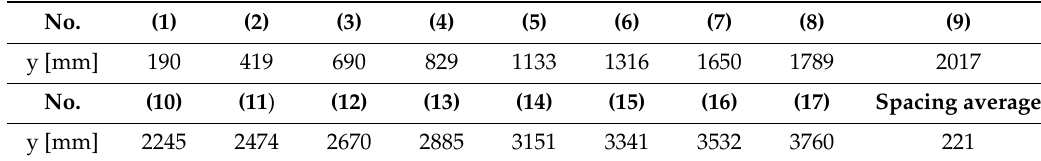
Figure 17. Pieces’ positions on panel block: ( a ) details of 17 pieces and ( b ) details of 10 pieces. Table 5. Positions of 17 pieces on panel block (a).